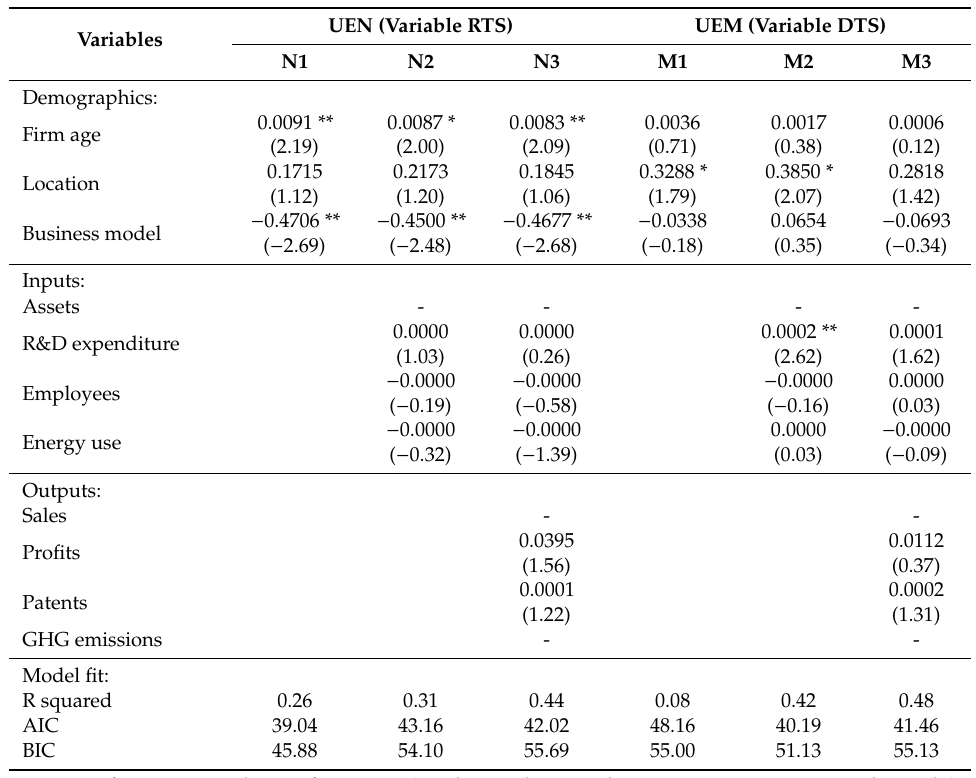
Table 7. Summary of Tobit